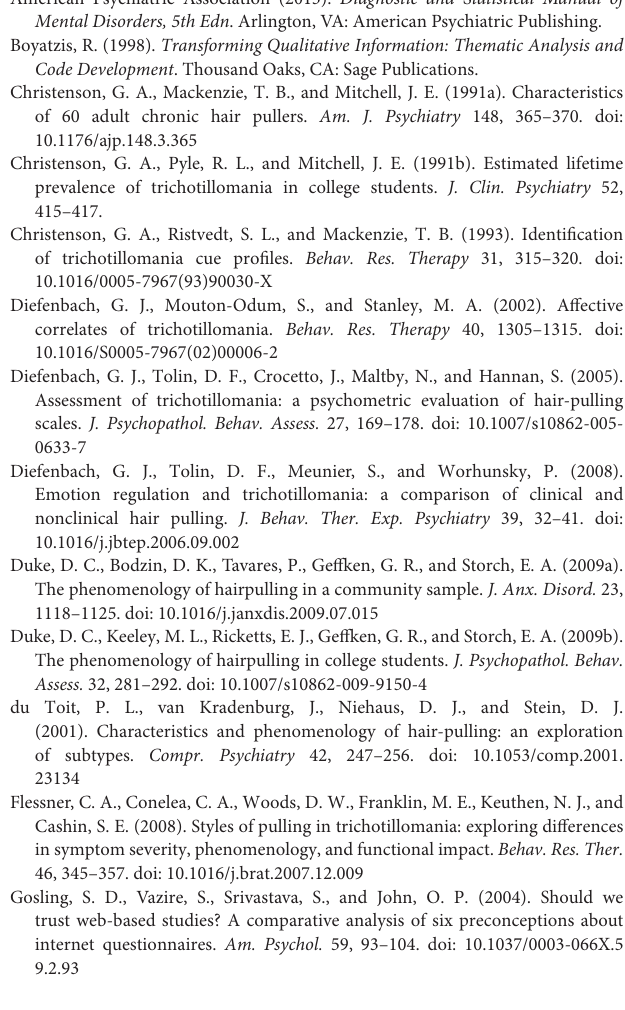
Supplementary Figure 1 | Mean differences between hair-pulling urge properties and unhealthy food urge properties. UF − group: Mean differences between likert (0–4) scale responses on the Massachusetts General Hospital Hairpulling Scale (MGH-HPS) and the analogous Unhealthy Food Scale (UFS). Error bars show 99.3% confidence intervals to reflect the adjusted alpha level, which was set to 0.007 to correct for familywise error rate. Supplementary Figure 2 | Head to head comparisons of hair pulling and unhealthy food urges. UF − group: Histograms of responses to head-to-head questions asking participants to directly compare hair pulling and unhealthy food urges with respect to some property. For each urge property (frequency, intensity, difficulty of resisting, attempts to resist, and distress), participants indicated either that unhealthy food (UF) urges were equal in severity to hair pulling (HP) urges, or